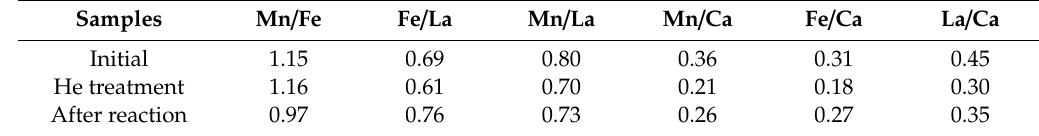
Table 4. The ratio of atomic concentrations of the elements presented in the studied samples.